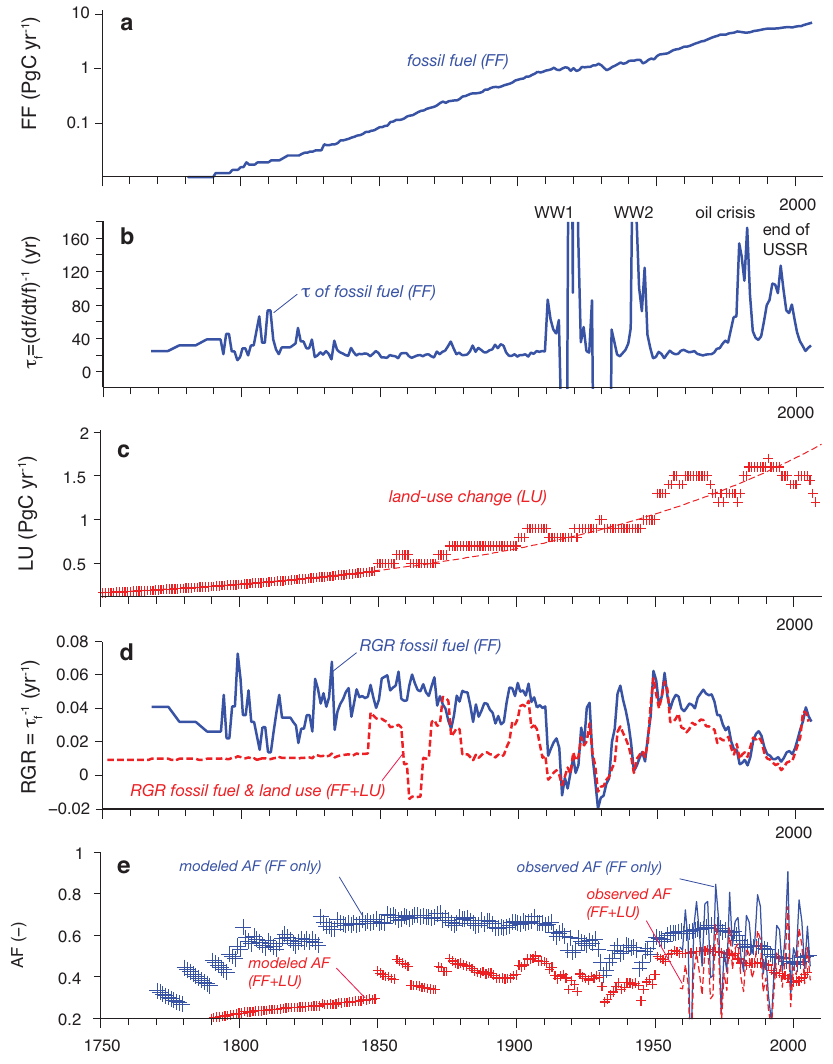
Fig. 1. (a) Fossil fuel emissions estimated by Marland (2006), (b) time scale τ f of relative rate of change of FF, (c) carbon flux to the atmosphere due to land use change estimated by Houghton et al. (2007), (d) relative growth rate of f =FF and f =FF+LU respectively, and (e) model predicted and observed AF FF and AF FF + LU